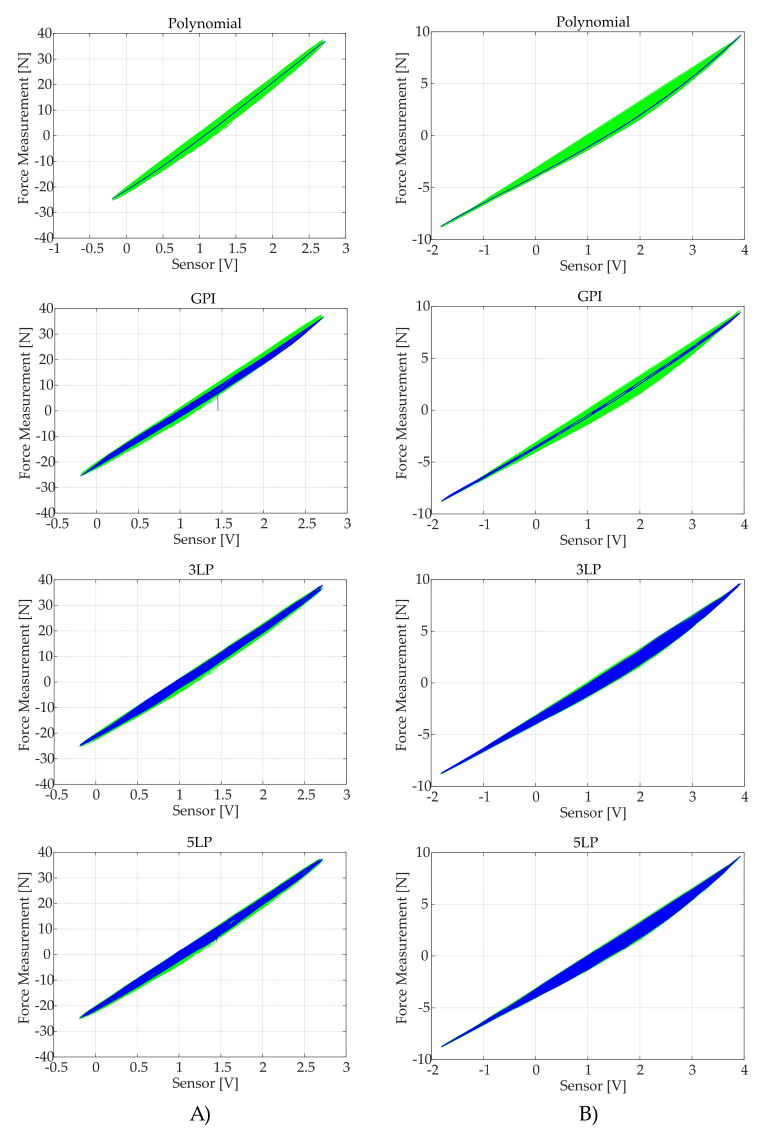
Figure A1. Response of each computed model (blue) superposed to the calibration data (green), where ( A ) corresponds to the data of the PLA based sensor and ( B ) to the steel based